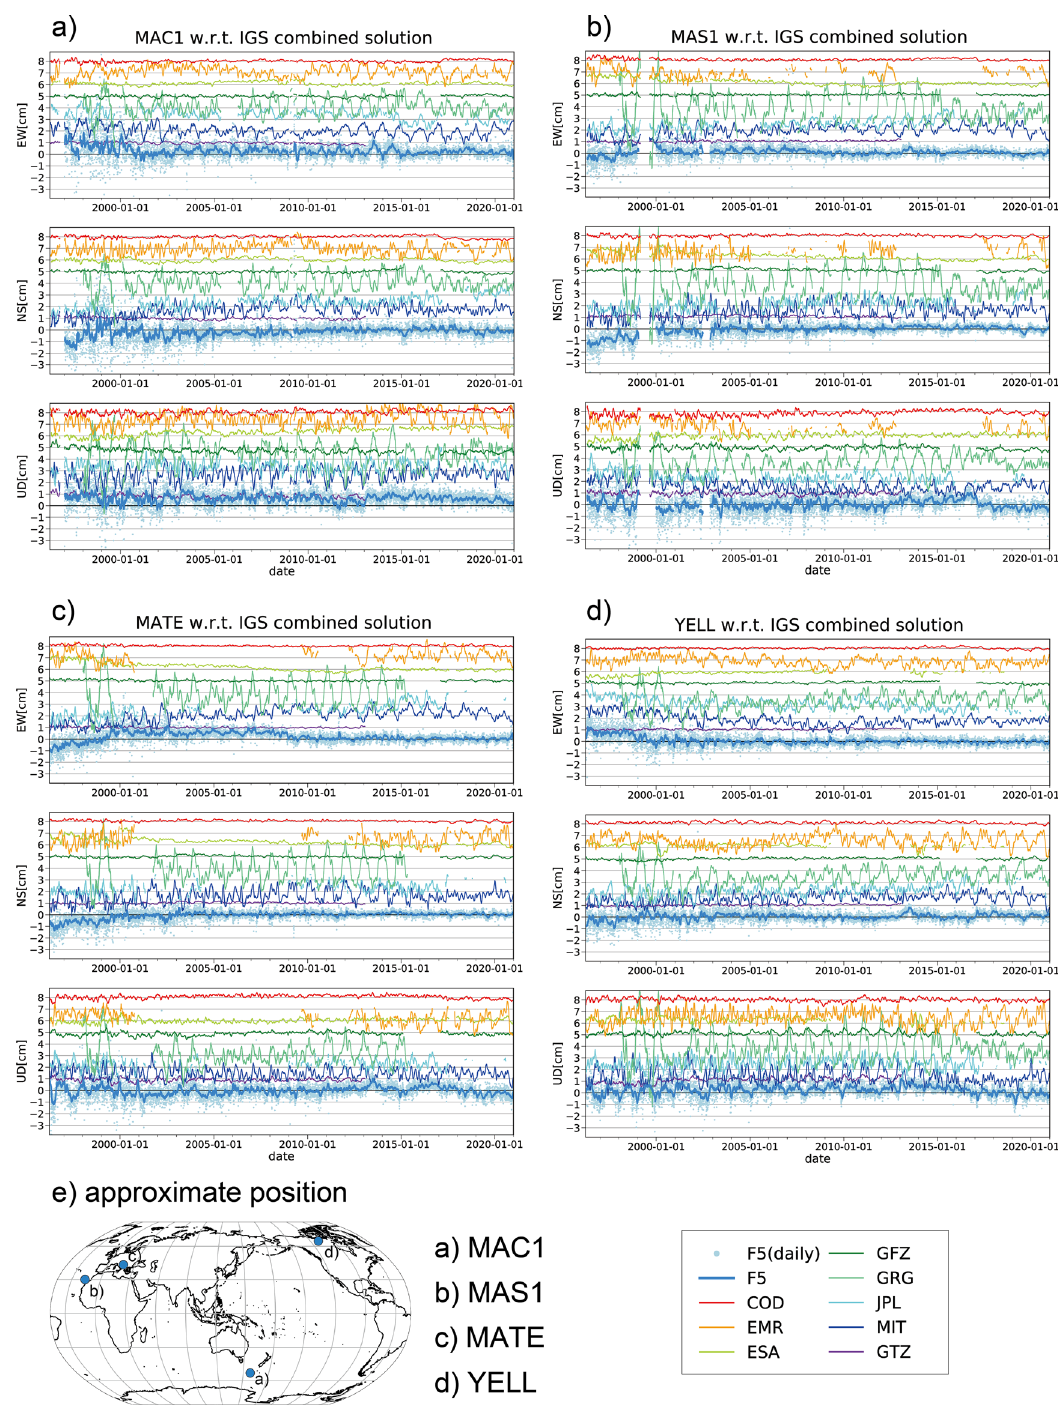
Fig. 4 Station coordinate time series at a MAC1, b MAS1, c MATE, and d YELL with respect to the IGS combined solution. Their approximate positions are plotted in e . The 28-day moving average was plotted by the solid lines. The daily coordinates of F5 were also plotted by the dots. Each AC’s time series was drawn with a constant interval of 1 cm for clear visibility. ULR was eliminated because the temporal variation was too large to draw a consistent